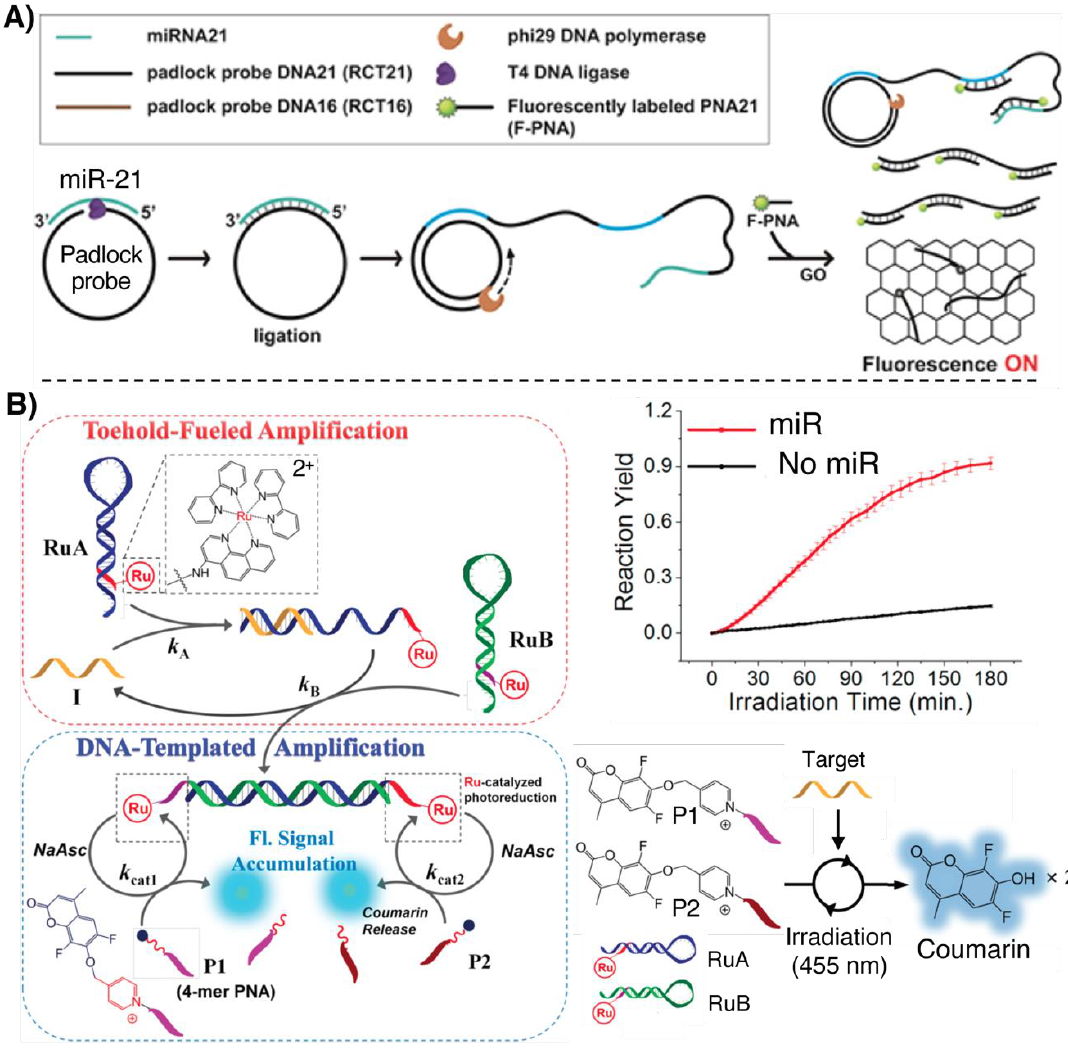
Figure 7. Illustration of some of the principal fluorescence-based methodologies for miR detection relying on PNAs, featuring a signal amplification strategy. ( A ) RCA-based detection of miR, adapted with permission from [98]. Copyright 2016 American Chemical Society. ( B ) Quadratic amplification applied for miR detection and release of coumarin, adapted with permission from [99]. Copyright 2019 American Chemical Society.